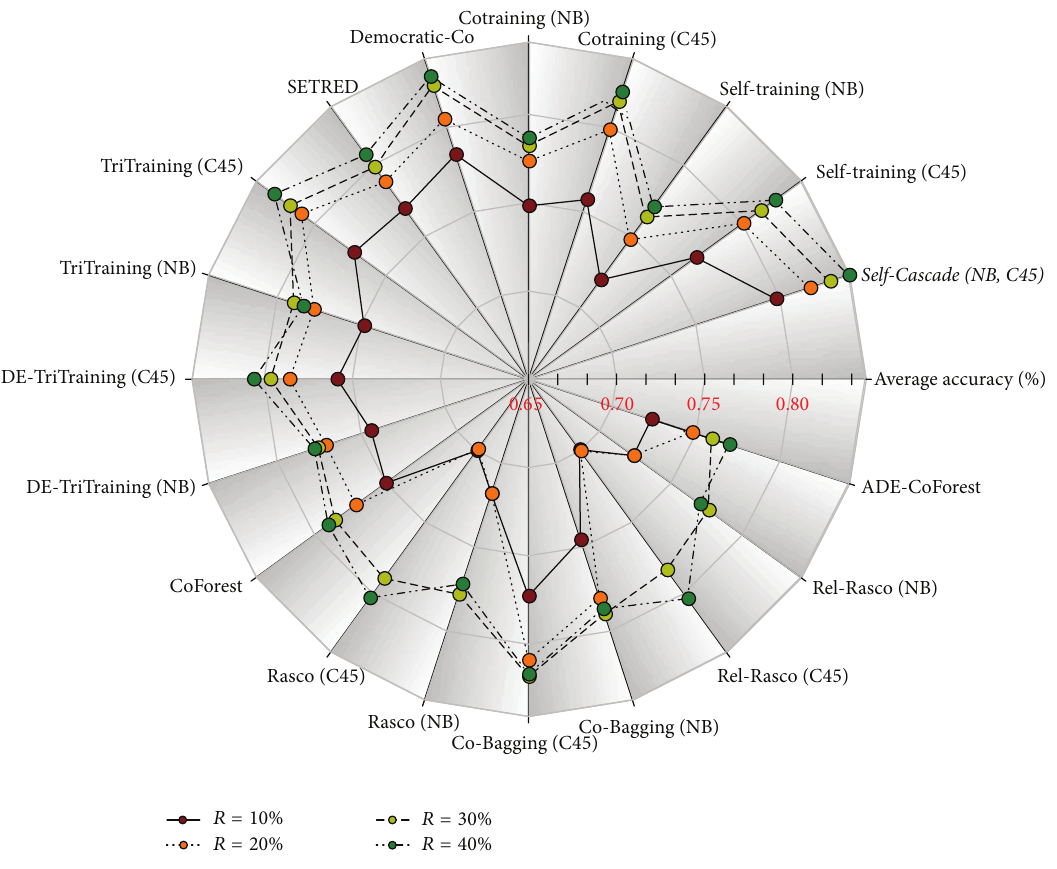
Figure 2: Comparison of average accuracy on benchmark